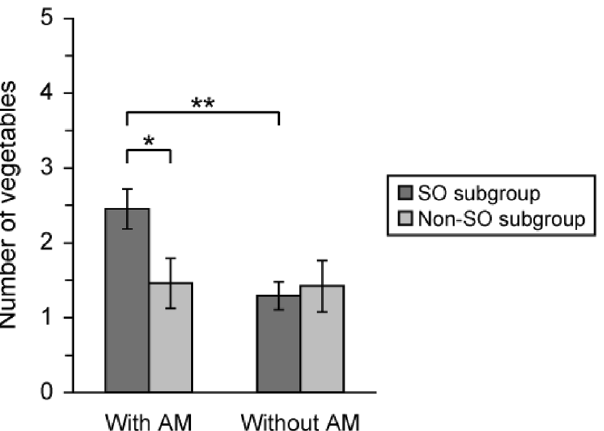
Figure 3. Number of nostalgic vegetables with and without autobiographical memories in each seasonality subgroup. Number of nostalgic vegetables with and without associated autobiographical memories in the SO and non-SO subgroups. Two-way mixed-design ANOVA revealed a significant interaction between seasonality subgroup and autobiographical memory ( F (1, 193) = 5.10, p < 0.05). AM: autobiographical memory. Error bar: standard error (SE). *** p < 0.001, * p < 0.05.